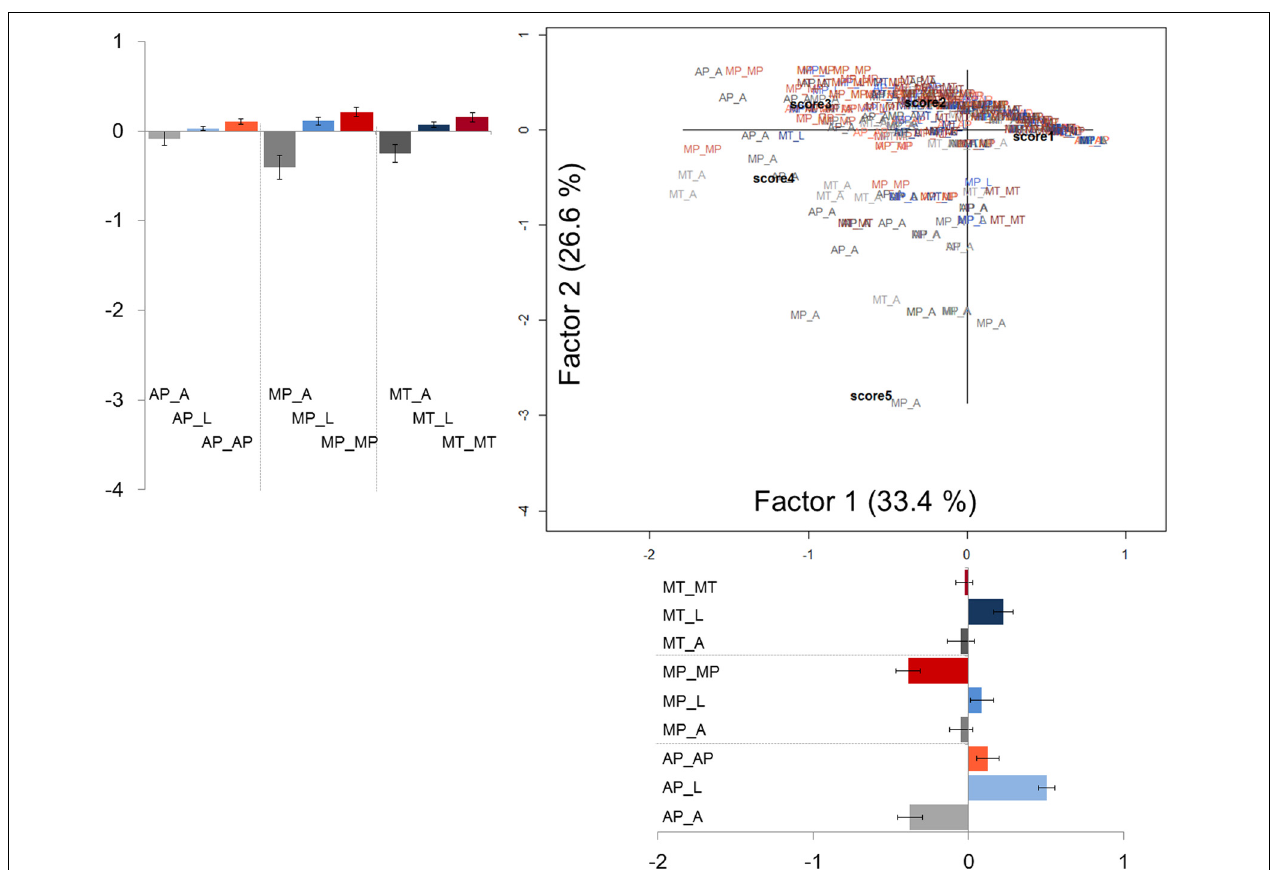
FIGURE 2 | Correspondence analysis for difficulty rating scores. Labels as in Figure 1